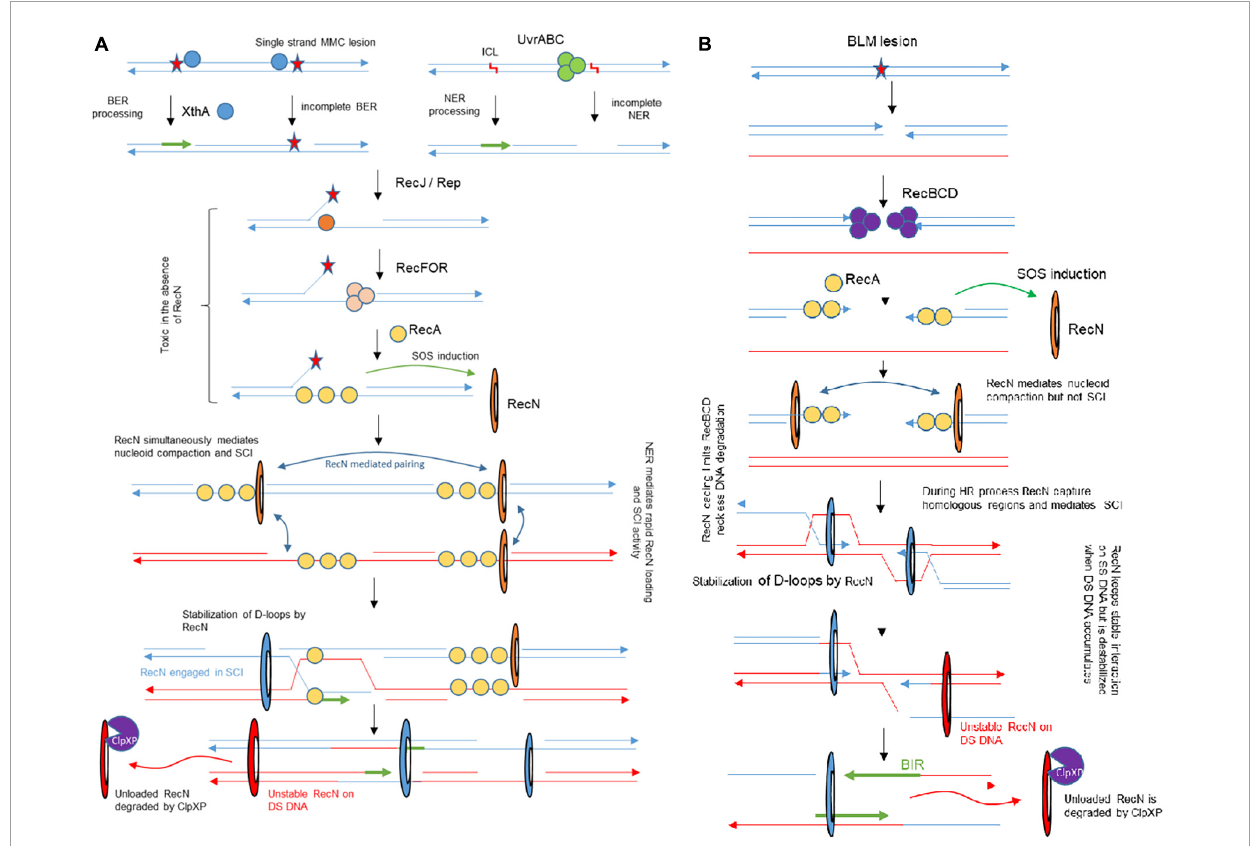
FIGURE7 Integrated model for genotoxic stress response accompanying MMC and BLM induced lesions and its impact on SCI. (A) The NER and BER pathway are involved in MMC tolerance. Our results show that early processing by NER or BER are required for RecN activity, presumably for its loading. In the absence of RecN, BER intermediates become toxic for the cell. RecN plays multiple roles in the following steps of the process, it mediates nucleoid compaction, SCI and facilitates RecA mediated D-loops. When SS-SNA disappear, RecN dissociates from the DNA and is degraded. (B) In the presence of BLM, the RecBCD pathway allows SOS induction and RecN loading. RecN contributes to limit RecBCD reckless DNA degradation. Although RecN impact on nucleoid compaction manifests as early as the one observed in the presence of MMC, its influence on SCI is delayed.